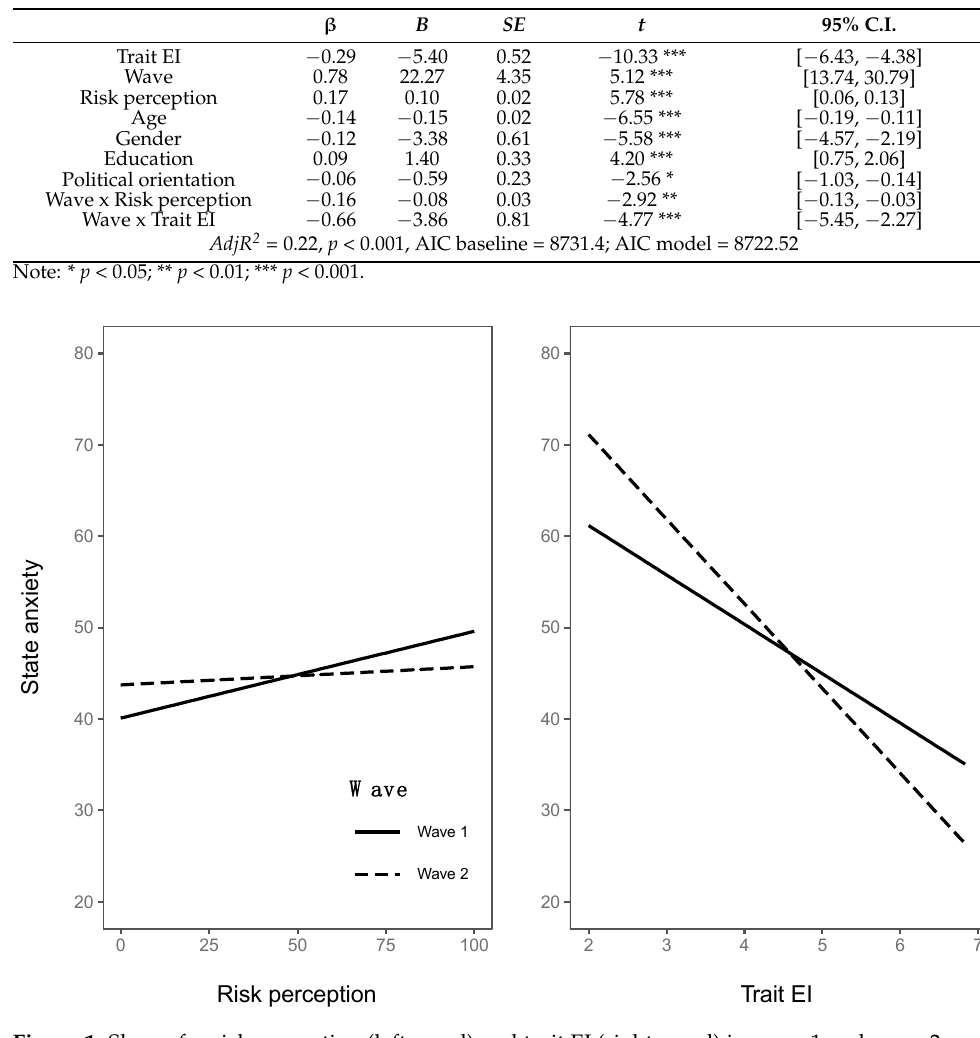
Figure 1. Slopes for risk perception (left panel) and trait EI (right panel) in wave 1 and wave 2.